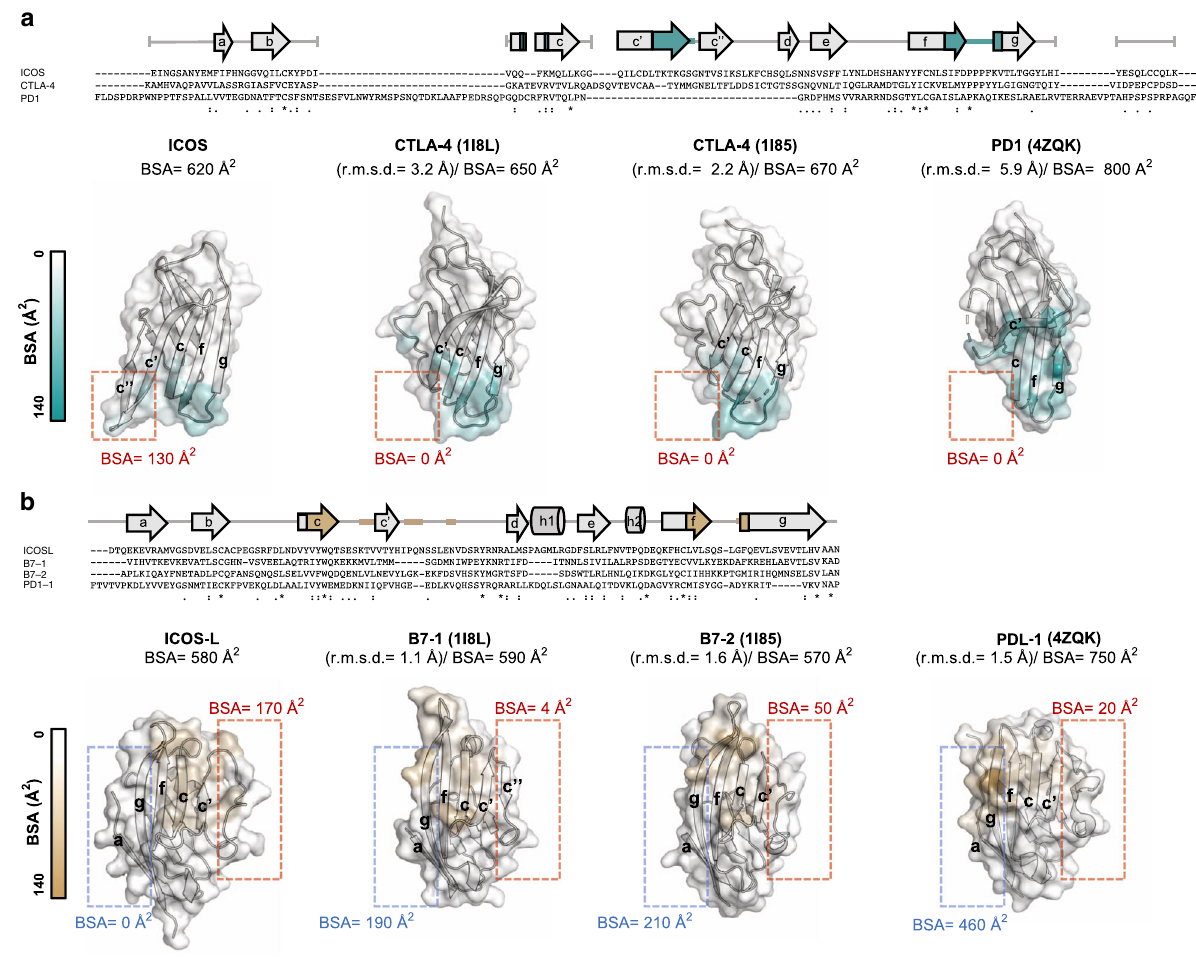
Fig. 3 Speci fi city of the ICOS and ICOS-L interaction. Sequence alignment of ( a ), ICOS with CTLA-4 and PD1 and b , ICOS-L with B7-1, B7-2, and PDL-1. Invariant residues (asterisk), and residues with highly (colon) and weakly similar properties (dot) are indicated. Strands and α helixes are denoted by arrows and cylinders, respectively. Secondary structure cartoon representation of ( a ), the V-type domains of ICOS in comparison with CTLA-4 (PDB IDs: 1I8L and 1I85) and PD1 (PDB ID: 4ZQK) and ( b ), ICOS-L in comparison with B7-1 (PDB ID: 1I8L), B7-2 (PDB ID: 1I85) and PDL-1 (PDB ID: 4ZQK). Backbone r.m.s.d. between ICOS and ICOS-L and structures of other family members is shown in parentheses and were calculated in Pymol 70 . Residues are shown as surface and colored according to their BSA. Areas with higher and lower BSA in ICOS and ICOS-L with respect to the other family members are boxed in red and blue, respectively. The total BSA of each ectodomain is